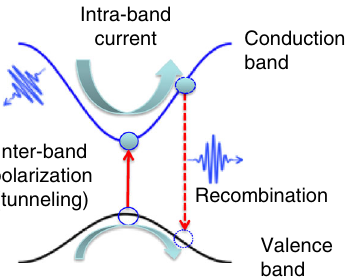
Fig. 6 Momentum-space interpretation for HHG in solid materials. The microscopic mechanism for solid-state HHG showing two major channels semiclassically. The laser fi eld promotes an electron from valence to conduction band leaving behind a hole in the valence band, as shown by the vertical solid line. Both the electron and hole are accelerated in their respective bands. Channel 1: the nonlinear intraband current in the conduction band can radiate. Channel 2: the electron can recombine with the hole at a later time, as shown by the dashed line, and emit a high- energy photon. Adapted with permission from ref. 14 , Copyright 2019, Springer